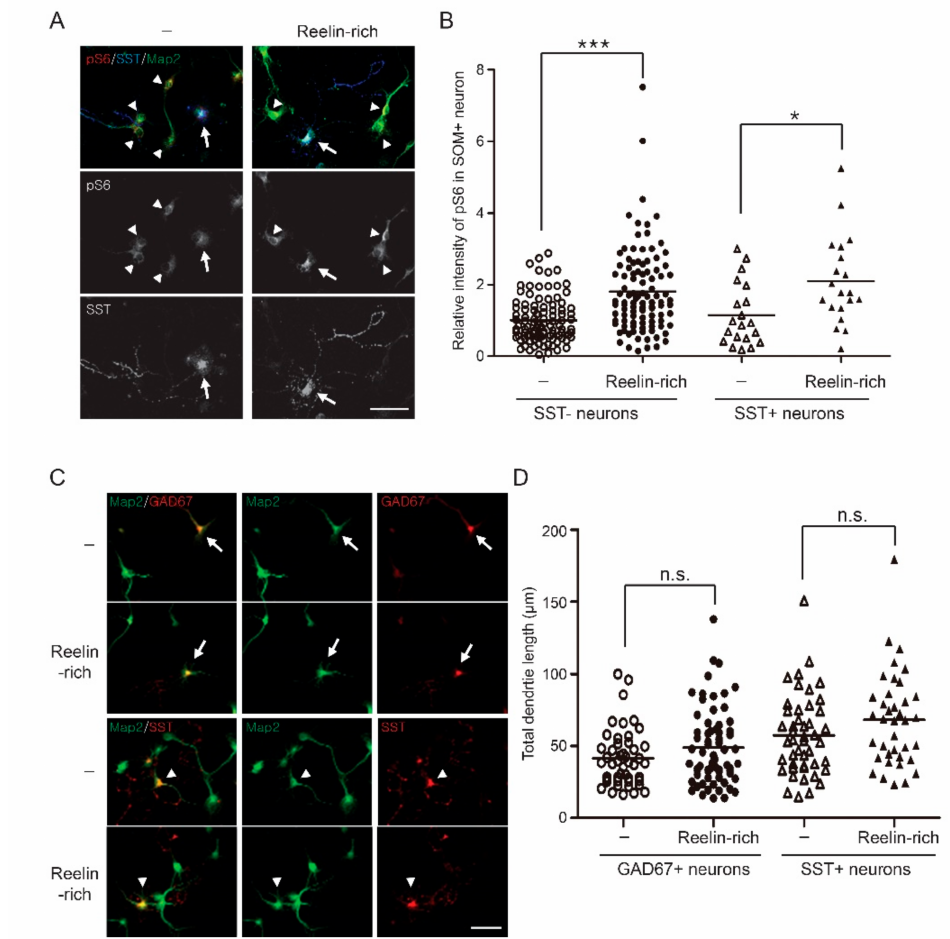
Figure 3. Reelin-rich protein-induced phosphorylation of S6 without dendrite outgrowth effect in SST-positive inhibitory neurons: ( A ) Five-day in vitro hippocampal neurons were supplemented with Reelin-rich protein for 20 min and imaged by confocal microscopy using Map2, GAD67, or phospho-S6 (serine 235/236) antibodies. Somatostatin-positive inhibitory neurons are indicated with arrows and somatostatin-negative excitatory neurons with arrowheads. ( B ) The fluorescence intensity of the soma was quantified and the sample distribution of individual SST-positive inhibitory neurons is shown (number of SST-negative neurons = 99–102, number of SST-positive inhibitory neurons = 20). ( C ) Four-day in vitro hippocampal neurons were supplemented with Reelin-rich protein for 24 h and imaged by confocal microscope using Map2, GAD67, or somatostatin antibodies. GAD67-positive inhibitory neurons are indicated with arrows and somatostatin-positive inhibitory neurons with arrowheads. ( D ) Fluorescence intensity quantification and sample distribution of individual hippocampal neurons (number of GAD67-positive inhibitory neurons = 47–67, number of SST-positive inhibitory neurons = 38–46). No significant differences in dendrite outgrowth were observed between most inhibitory neurons and SST-expressing neurons. The results were analyzed using the Kruskal–Wallis test followed by Dunn’s comparison test. Note: * p < 0.05, *** p < 0.001; n.s., nonsignificant. Scale bar, 50 µ